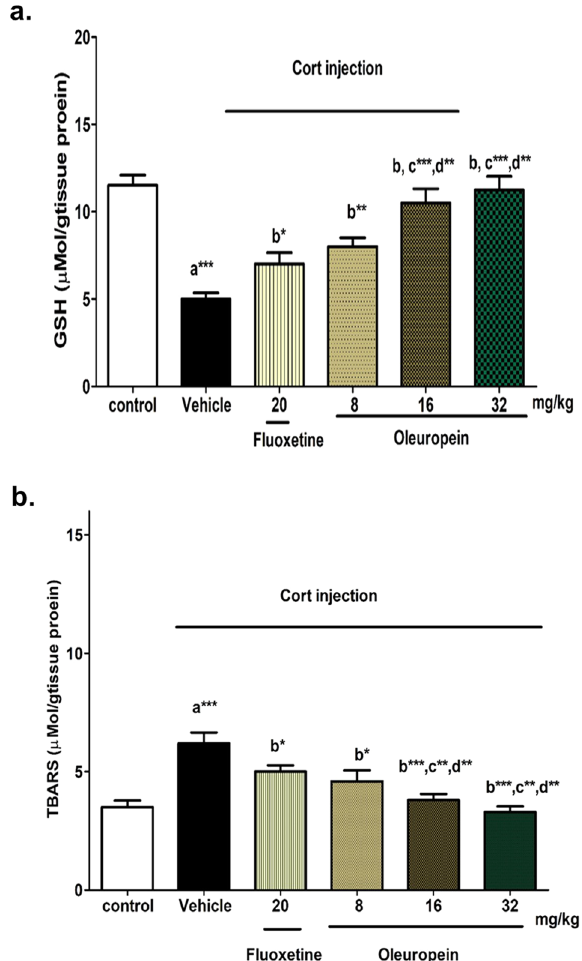
Figure 3. Effects of different doses of oleuropein on oxidative stress-related parameters in chronic Cort- induced depression model. ( a ) Reduced Glutathione (GSH); u Mol/g tissue protein; and ( b ) Thiobarbituric Acid Reactive Substances (TBARS); u Mol/g tissue protein in different animal groups. Each bar represents the mean of 6 rats + SEM. a: significant compared to the control group; b: significant compared to the Cort group; c: significant compared to Cort + Fluoxetine group; d: significant compared to Cort + oleuropein (8 mg/kg) group. * p ≤ 0.05, ** p ≤ 0.01, *** p ≤